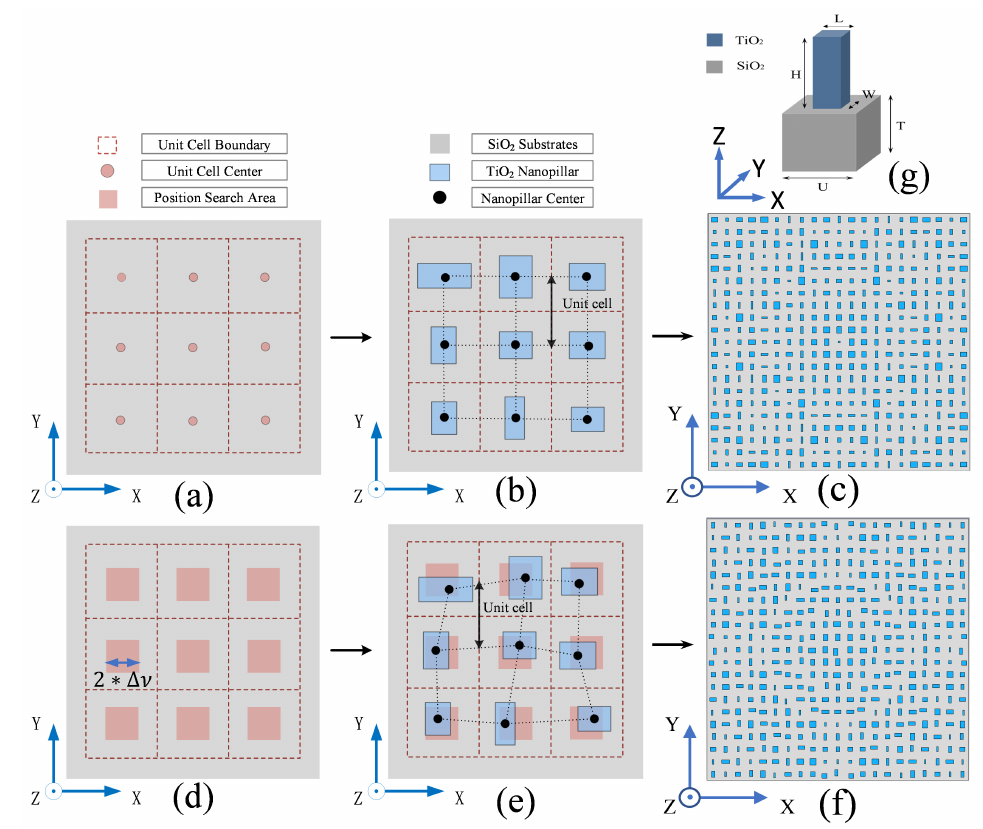
Figure 1. (Color online) The comparison schematics between the traditional and newly proposed methods. ( a ) The position distribution to build nanopillars in the traditional method. ( b ) The traditional method for designing a metasurface. The nanopillar transmittance is in a wide range, and the nanopillar placement is fixed and regular. ( c ) A traditional metalens designed with the traditional method. The nanopillars are regularly distributed. ( d ) The search area distribution to build meta-atoms in the newly proposed method. ( e ) The newly proposed method for designing a metasurface. The nanopillar transmittance is high and uniform, and the nanopillar arrangement is irregular. ( f ) The position modified metalens intended with the new approach. ( g ) The stereogram of the unit cell, where U = 400 nm, T = 400 nm, H = 500 nm, and L , W ∈ [ 50,250 ] nm with a step of 5